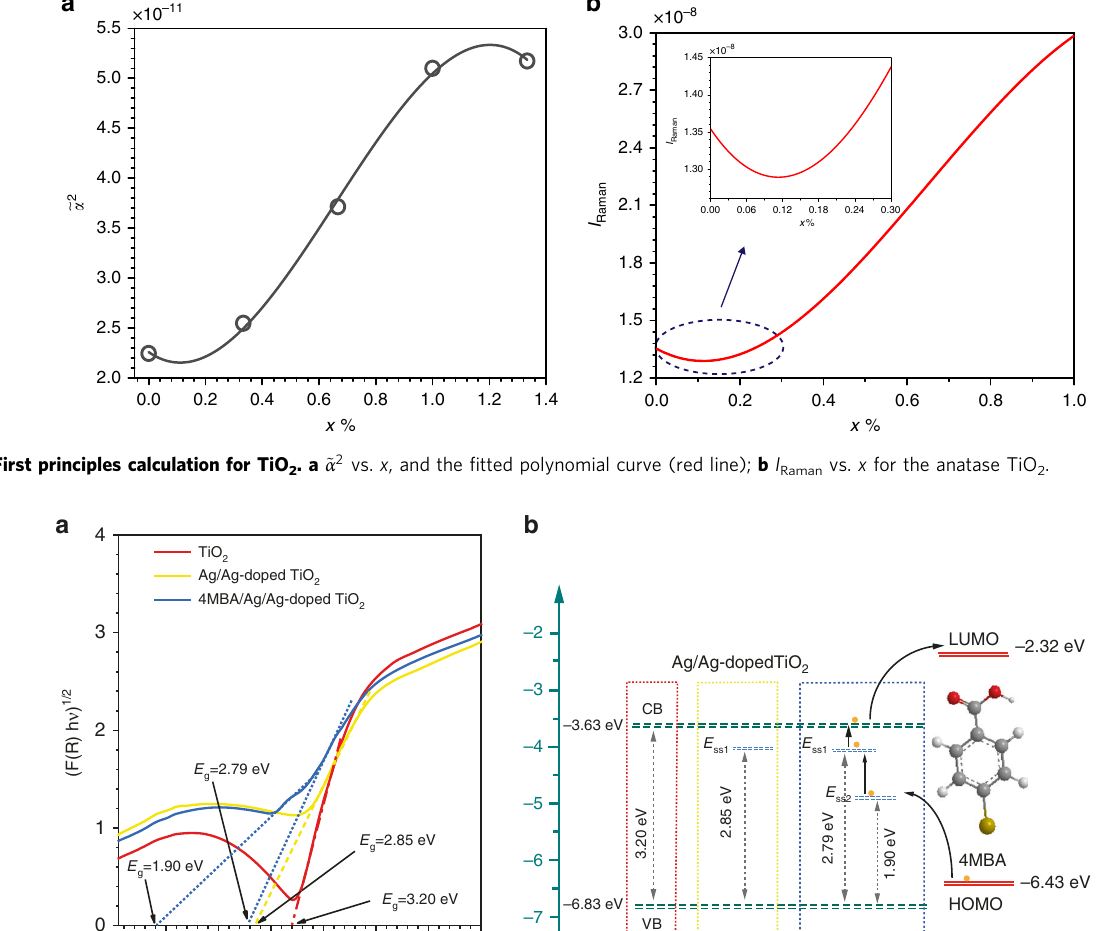
Fig. 6b, the direct transition of electrons from the VB of TiO 2 to E ss2